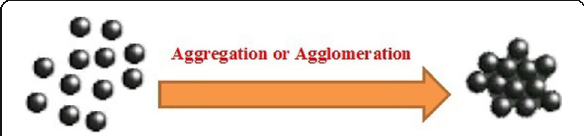
Fig. 1 Schematic illustration of aggregation/agglomeration of nanoparticles in polymer nanocomposites. When several nanoparticles with radius R are aggregated/agglomerated, a large particle is